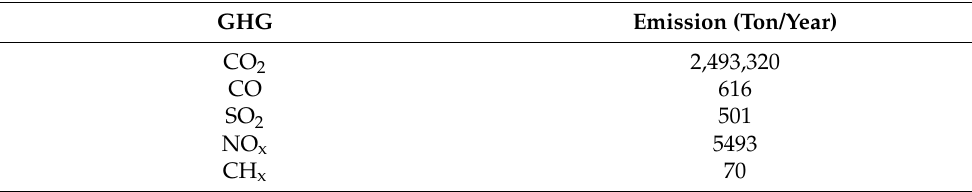
Table 6. The avoidance of pollution due to the GHG emissions when using diesel generators instead of using HRES with 100% green resources [70]. Reproduced from [70], Elsevier: 2014.